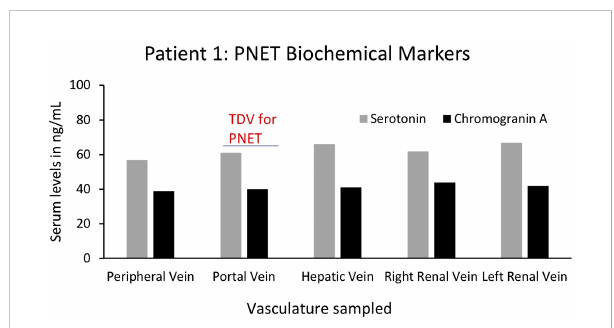
FIGURE 12 Serum levels of biochemical markers serotonin and chromogranin A for Patient 1 ’ s PNET in tumor-draining and peripheral veins. Levels of known PNET biomarkers, serotonin (grey bars) and chromogranin A (black bars), were not substantially different in blood samples from different vascular venous bed samples and were not enriched in the portal vein, the TDV1 for the PNET. It should be noted that sandostatin (200µg) was administered prior to procedures (that included endovascular venous sampling sessions), to limit serotonin release from the PNET during portal vein stenting procedures and this could have impacted TDV levels of this